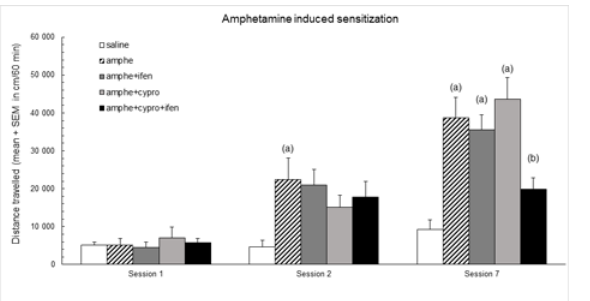
Fig 1. Effect of ifenprodil and cyproheptadine treatments on the d-amphetamine-induced sensitization. Session 1: all groups received two saline administrations, 15 min and 30 min after being placed in the actimeter. Then, all amphetamine groups are treated with amphetamine (2 mg/kg) as indicated in materials and methods. Sessions 2 and 7: groups received saline or ifenprodil 1 mg/kg or/and cyproheptadine 1 mg/kg and then saline and amphetamine, as indicated in materials and methods. — Y axis: distance travelled in cm (mean ± S.E.M.). Statistical analyses: repeated measures ANOVA, group effect F 4;35 = 9.0, p < 0.001, session effect F 2;70 = 63.2, p < 0.001, group × session interaction F 8;70 = 5.2, p < 0.001; one-way ANOVAs, differences between groups in session 1 F 4;35 = 0.2, p = ns; in session 2 F 4;35 = 3.0, p < 0.05, in session 7 F 4;35